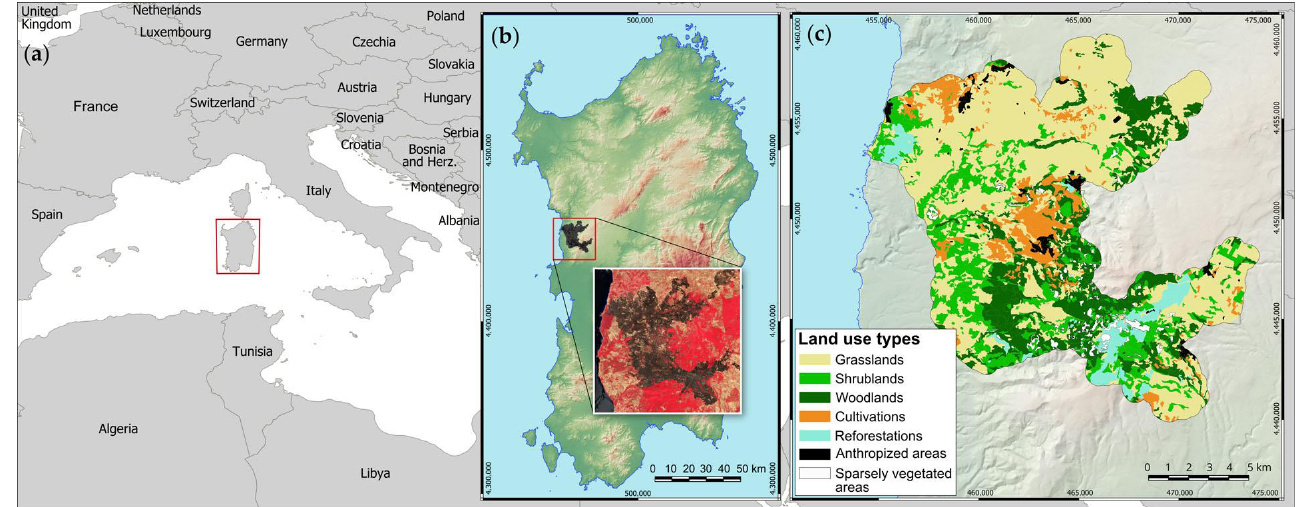
Figure 1. Location of the study area. ( a ) Location of Sardinia region (Italy). ( b ) Focus map of the region with the location of the study area. The image superimposed on the map shows in false colors (based on NIR, red, and green bands) a detail of the area struck by the megafire. ( c ) A map of land use types in the study area. The reference system is WGS84 – UTM.